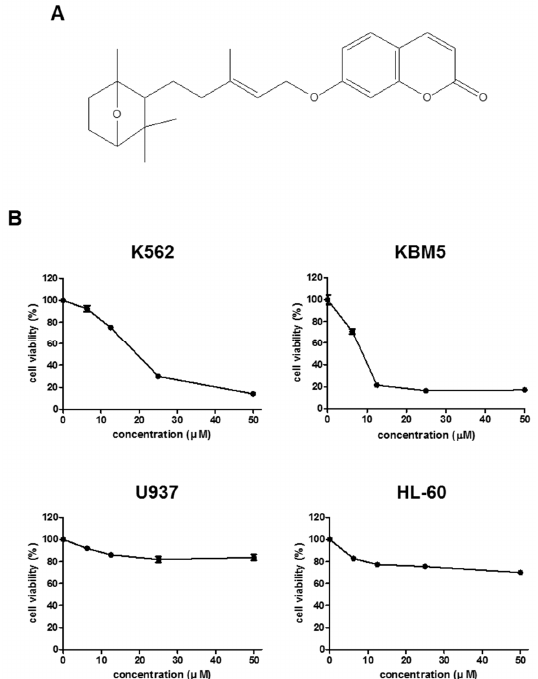
Figure 1. Cytotoxic effect of Farnesiferol C (FC) in leukemia. ( A ) Chemical structure of FC. ( B ) K562, KBM5, U937, and HL-60 cells were seeded into 96 well microplates and treated with various concentrations (10, 20, 30, 40, and 50 µM) of FC for 24 h. Cell viability was measured by 3-(4,5-Dimethylthiazol-2-yl)-2,5-diphenyltetrazolium bromide (MTT) assay. 2.2. FC Regulates Apoptosis Related Proteins and Induces G1 Arrest in CML Cells.